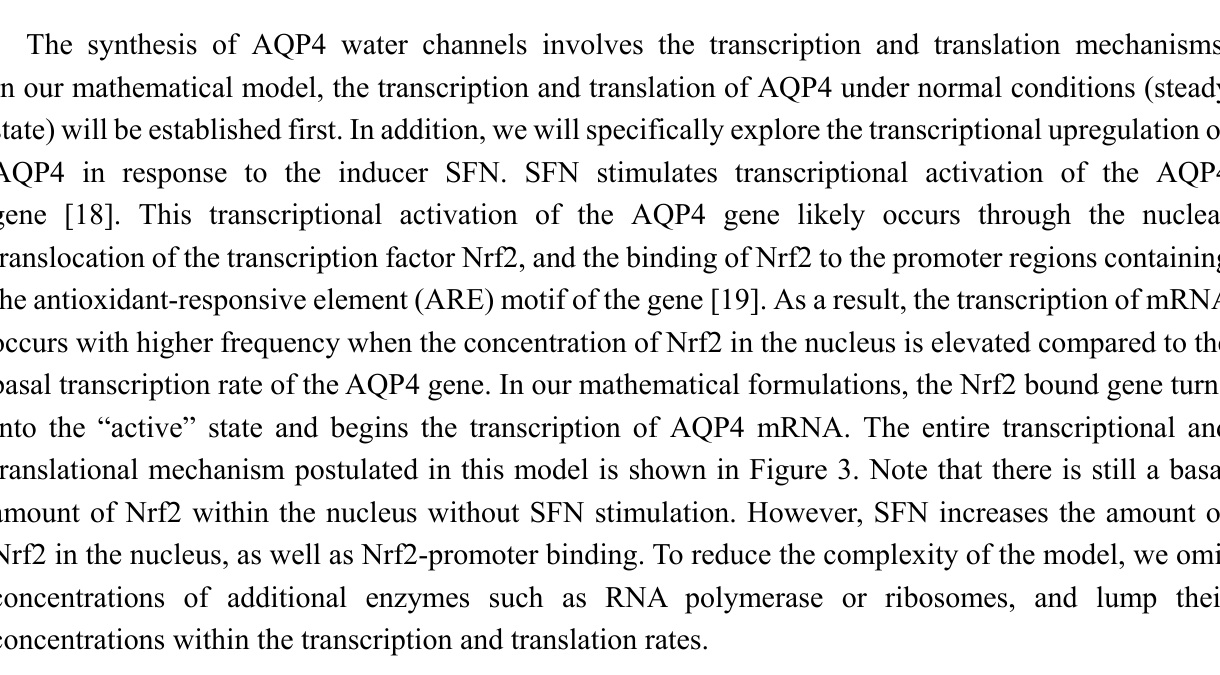
Figure 3. The modeling of AQP4 transcription and translation reaction mechanisms. Nrf2 activation by SFN treatment upregulates AQP4 expression in the astrocyte